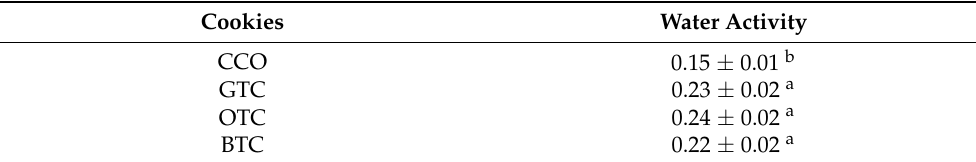
Table 6. The water activity of non-gluten shortbread cookies with various spent tea leaf powders.